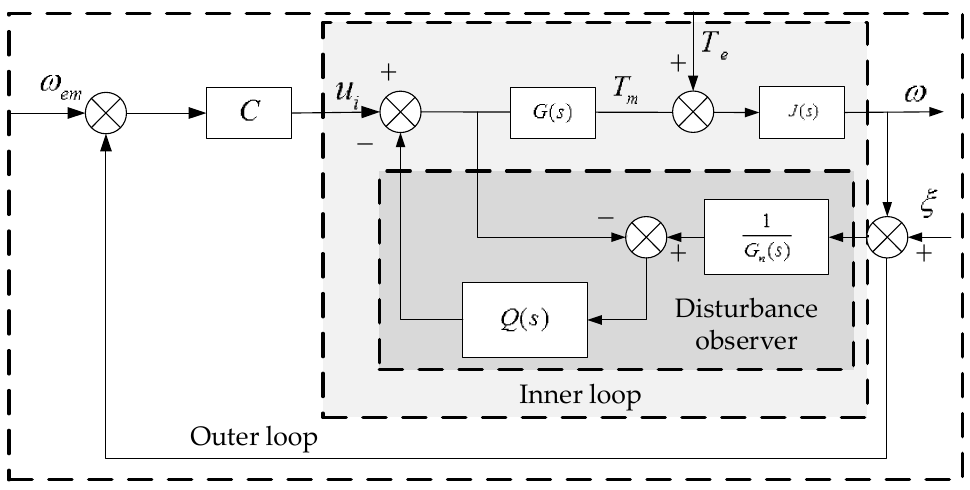
Figure 11. Control loop with a disturbance observer.